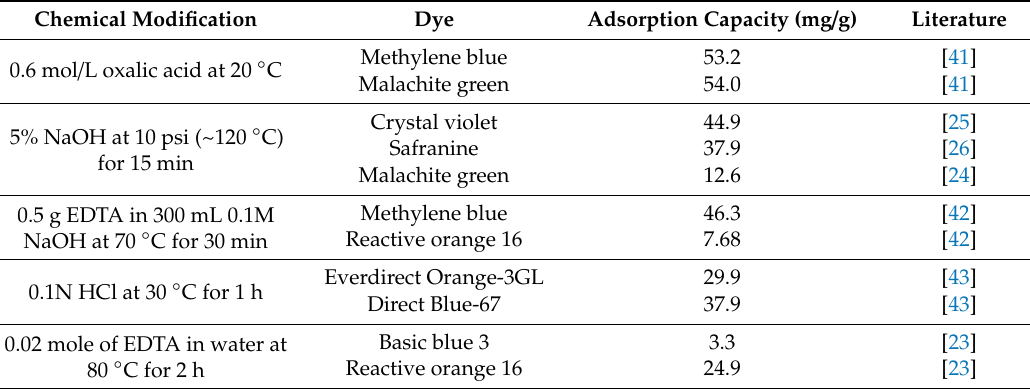
Table 6. Adsorption capacity of chemically modified rice husks.